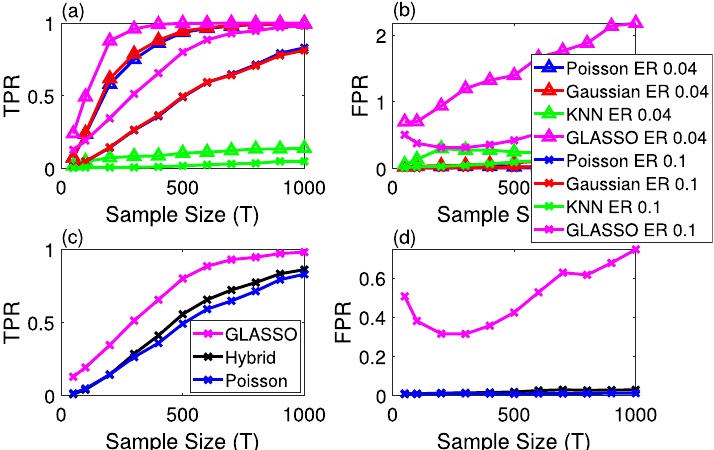
Fig. 4 True Positive and False Positive Rates for several test methods on ER graphs of two different levels of sparsity. Erdős-Rényi (ER) graphs with triangles for a 50 nodes graph with strong sparsity due to p = 0.04 , and the x’s for 50 nodes ER graphs with due to denser p = 0.1 . The magenta lines represent GLASSO, the blue lines represent the Poisson oMII, the red lines represent the Gaussian oMII, and the green lines represent the KNN oMII. In a the true positive rate (TPR) is shown for different sample sizes, each point is averaged over 50 realizations of the network dynamics. In b the false positive rate (FPR) is shown. Clearly GLASSO finds more true edges, but at the expense of a significantly higher false positives. In fact, for the highly sparse ER network GLASSO finds 3 times as many edges as actually exist in the network with 1000 data points. The FPR increases with data set. As can be seen the Gaussian oMII performs as well as Poisson oMII in TPR with the KNN performing poorly, but the Poisson oMII significantly outperforms all other methods in terms of FPR. It appears that the Poisson oMII is the only method that converges to the true network structure with increasing sample size. c Comparing TPR between GLASSO, the hybrid method and Poisson oCSE. The hybrid method has an increased TPR relative to Poisson oCSE. d The FPR increases slightly for the hybrid method, but is substantially lower than